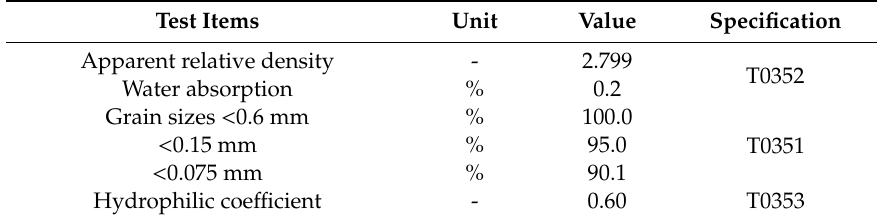
Table 4. Physical Properties of Mineral Filler.